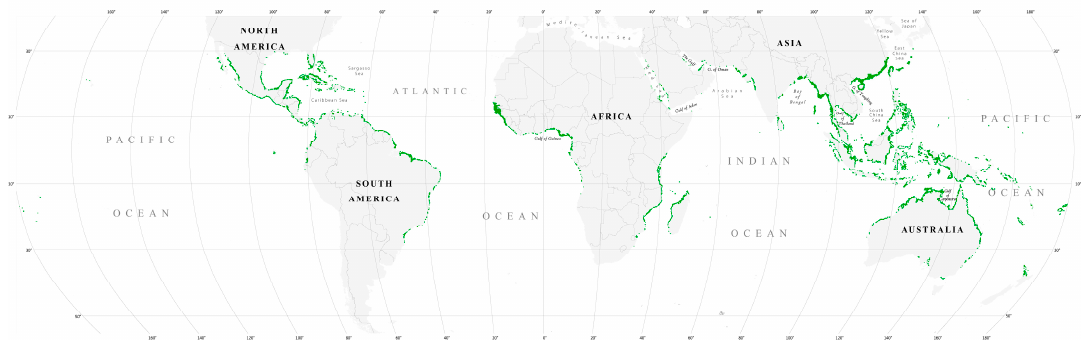
Figure 1. Distribution of the mangrove forests of the world for the year 2000 at 30 m spatial resolution [1].